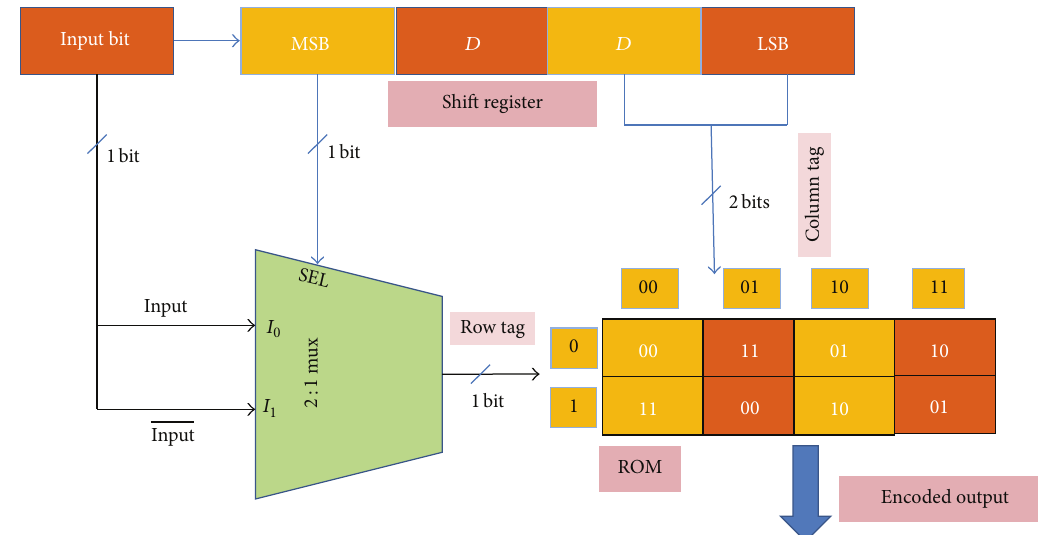
Figure 3: XOR-FREE architecture for GSM-900 standard with generator polynomials 𝑔 0 (𝑥) = (31) 8 and 𝑔 1 (𝑥) = (33) 8 .